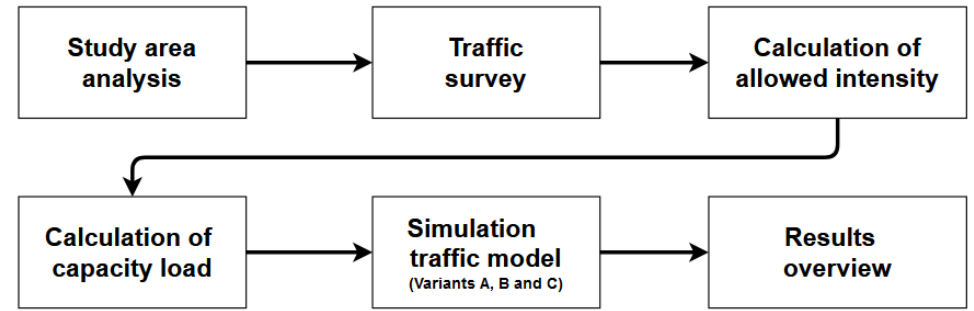
Figure 2. Research methodology (source elaborated by authors).